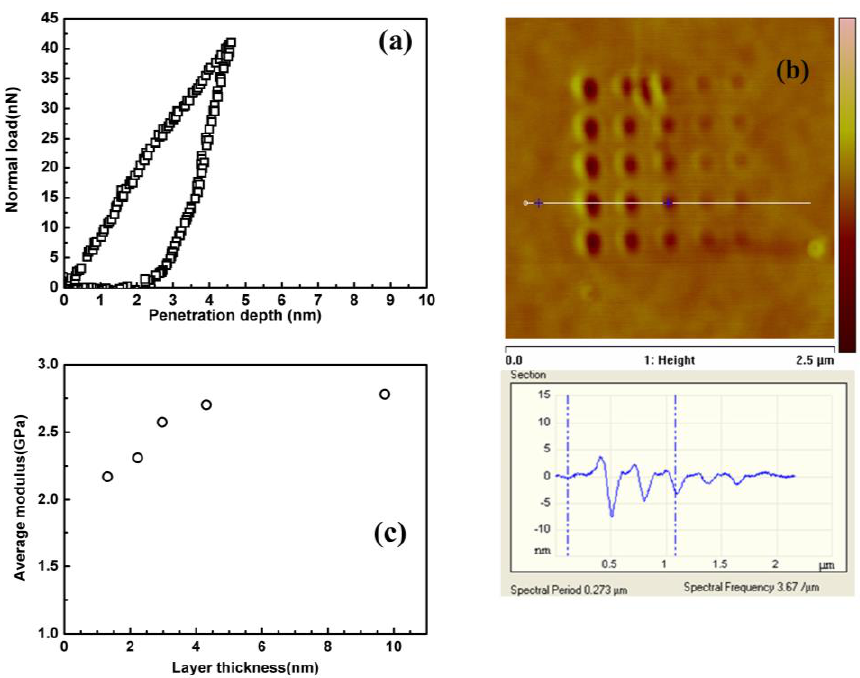
Figure 2. ( a ) Typical force-penetration depth, ( b ) AFM image, and ( c ) the variation of elastic modulus versus the indentation depth for PS thin film obtained by nanoindentaion.